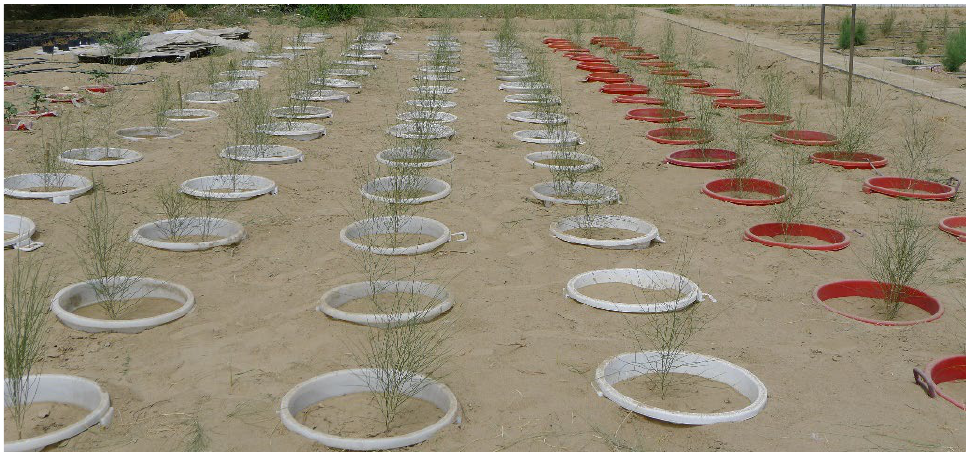
Figure 2. Experimental pots and growth status of C. caput-medusae after 2 months of water